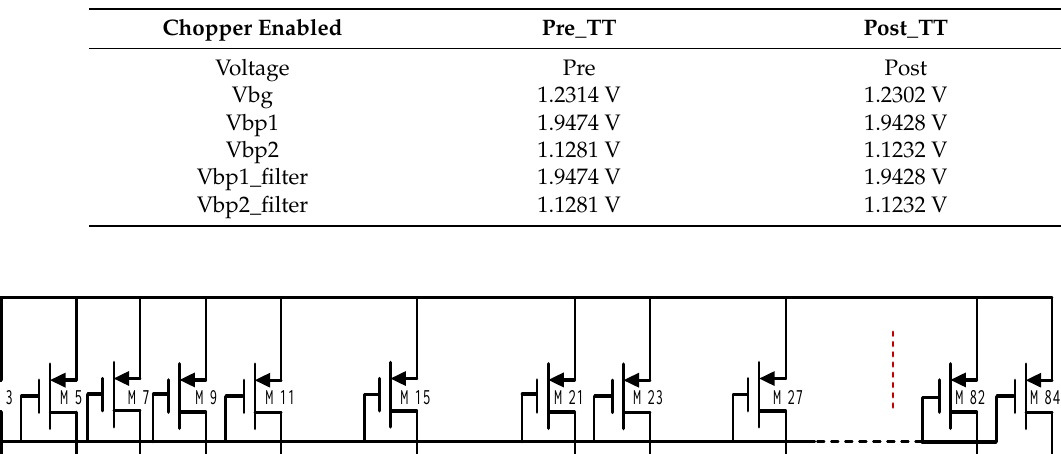
Table 6. Summary of bias circuit current post-simulation analysis. Table 4. Summary of the pre- and post-simulations.